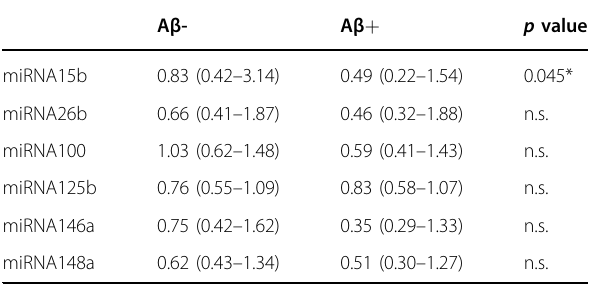
Table 2 Comparison of A β -PET subgroups for plasma concentrations of the six identi fi ed brain-enriched